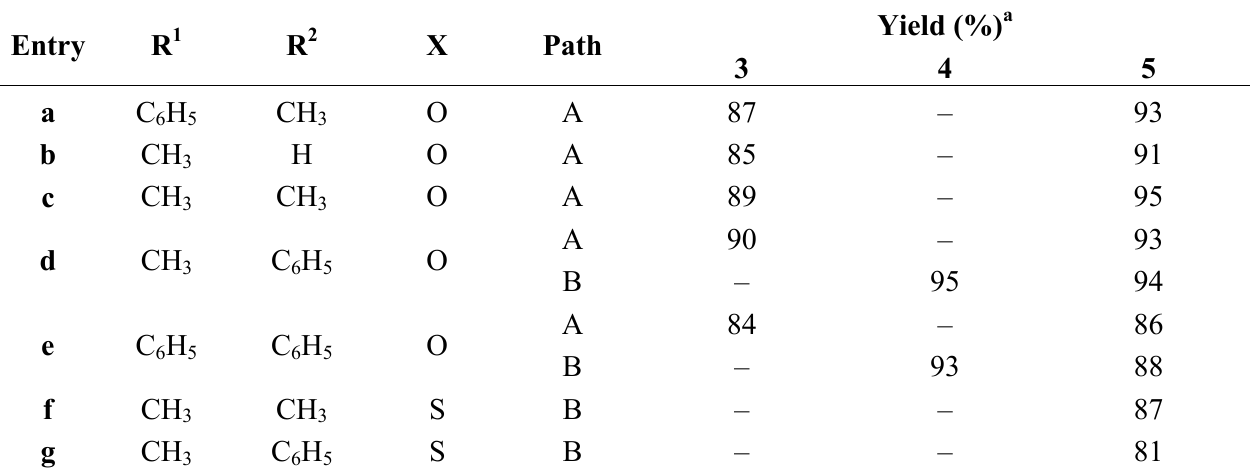
Table 1. Yields of intermediates ( 3 , 4 ) and end products 5 obtained according to Scheme